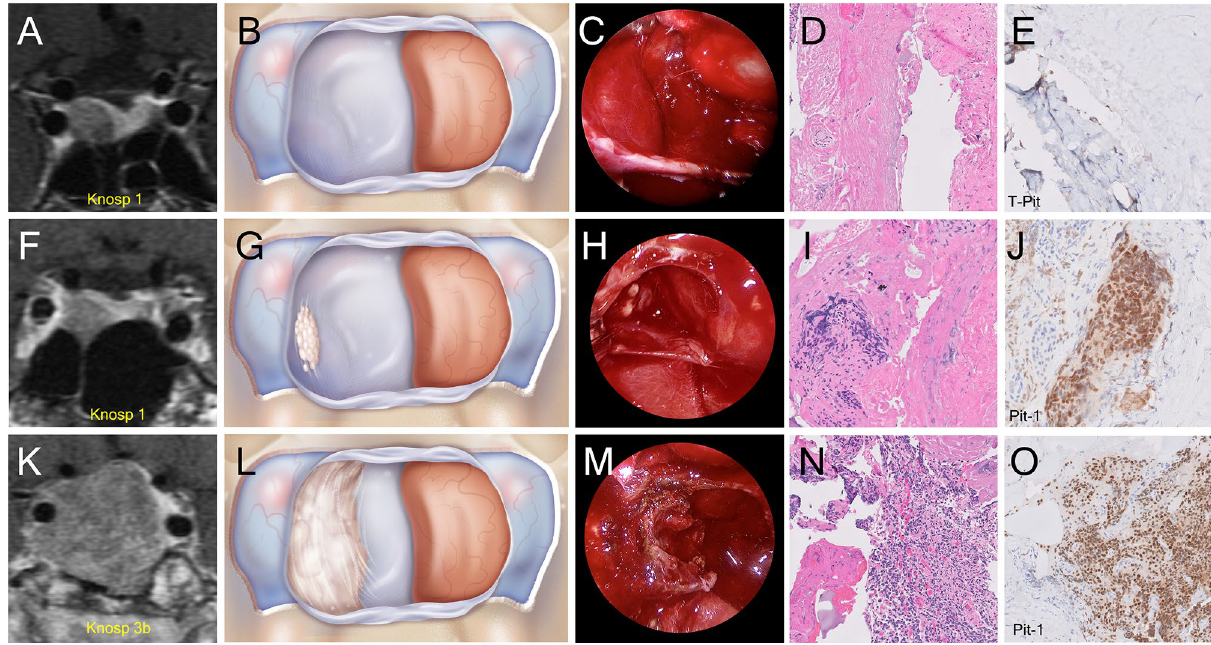
Figure 2. We hypothesized from our intraoperative experience with pituitary tumors that some pituitary adenoma subtypes have a predilection for invading the medial wall of the cavernous sinus more so than others. Case examples of various pituitary adenomas with varying Knosp grade and invasion into the medial wall of the cavernous as viewed on preoperative MRI (T1 with gadolinium), through medical illustrations, from an endoscopic intraoperative view, and microscopically with histological H&E staining and immunocytochemistry. ( A ) Preoperative coronal MRI demonstrating a Knosp grade 1 corticotroph adenoma ( B ) A medical illustration of the intraoperative view from an endoscopic transsphenoidal approach after the adenoma has been removed and the pituitary gland remains displaced the left side of the field exposing an intact medial of the cavernous sinus with no evidence of invasion ( C ) An intraoperative view from an endoscopic transsphenoidal approach after the adenoma has been removed and the pituitary gland remains displaced the left side of the field exposing an intact right medial wall of the cavernous sinus with no evidence of invasion ( D ) Histological images of H&E slides of a resected medial wall with no evidence of invading pituitary adenoma cells ( E ) Histological images of immunohistochemistry slides of a resected medial wall with no evidence of invading pituitary adenoma cells (staining for T-pit transcription factor) ( F ) Preoperative coronal MRI demonstrating a Knosp grade 1 somatotroph adenoma ( G ) A medical illustration of the intraoperative view from an endoscopic transsphenoidal approach after the adenoma has been removed and the pituitary gland remains displaced to the left side of the field exposing the right medial wall of the cavernous sinus with subtle evidence of tumor invasion ( H ) An intraoperative view from an endoscopic transsphenoidal approach after the adenoma has been removed and the pituitary gland remains displaced the left side of the field exposing the right medial wall of the cavernous sinus with subtle evidence of tumor invasion ( I ) Histological images of H&E slides of the resected medial wall with evidence of invading pituitary adenoma cells ( J ) Histological images of immunohistochemistry slides of the resected medial wall in the case with evidence of invading pituitary adenoma cells (staining for Pit-1 transcription factor) ( K ) Preoperative coronal MRI demonstrating a Knosp grade 3 somatotroph adenoma ( L ) A medical illustration of the intraoperative view from an endoscopic transsphenoidal approach after the adenoma has been removed and the pituitary gland remains displaced to the left side of the field exposing the right medial wall of the cavernous sinus with frank evidence of tumor invasion ( M ) An intraoperative view from an endoscopic transsphenoidal approach after the adenoma has been removed and the pituitary gland remains displaced the left side of the field exposing the right medial wall of the cavernous sinus with frank evidence of tumor invasion ( N ) Histological images of H&E slides of the resected medial wall in this case with evidence of invading pituitary adenoma cells O. Histological images of immunohistochemistry slides of the resected medial wall in this case with evidence of invading pituitary adenoma cells (staining for Pit-1 transcription